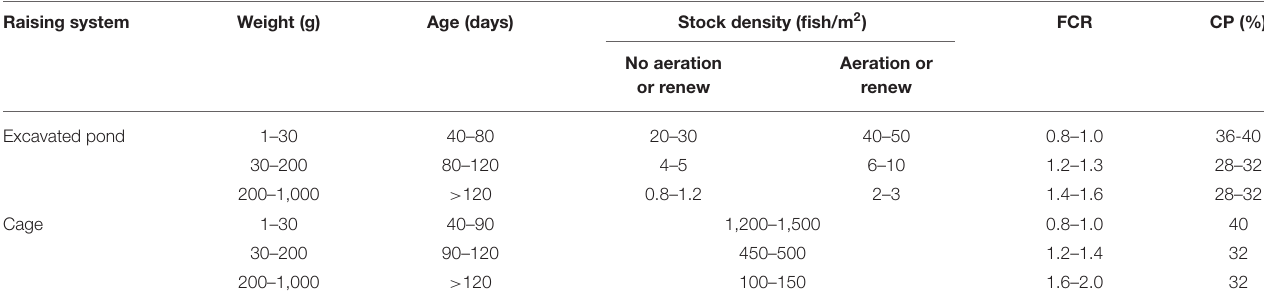
TABLE 4 | Different densities considered ideal according to the association between raising system and tilapia feed conversion ratio (FCR) and diet crude protein rate (CP), adapted from RSPCA (33). Raising system